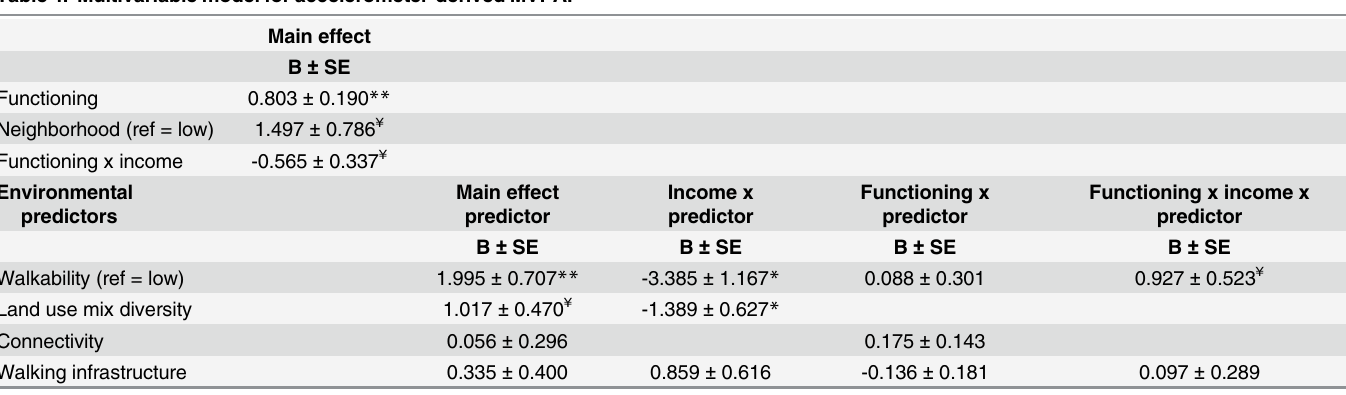
Table 4. Multivariable model for accelerometer-derived MVPA.